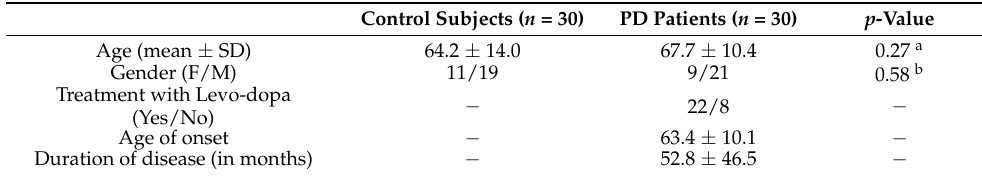
Table 1. Demographic characteristics of the study population.